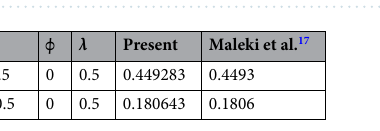
Figure 12. Impacts of ( a ) Ec ( b ) β ∗ on nusselt number.